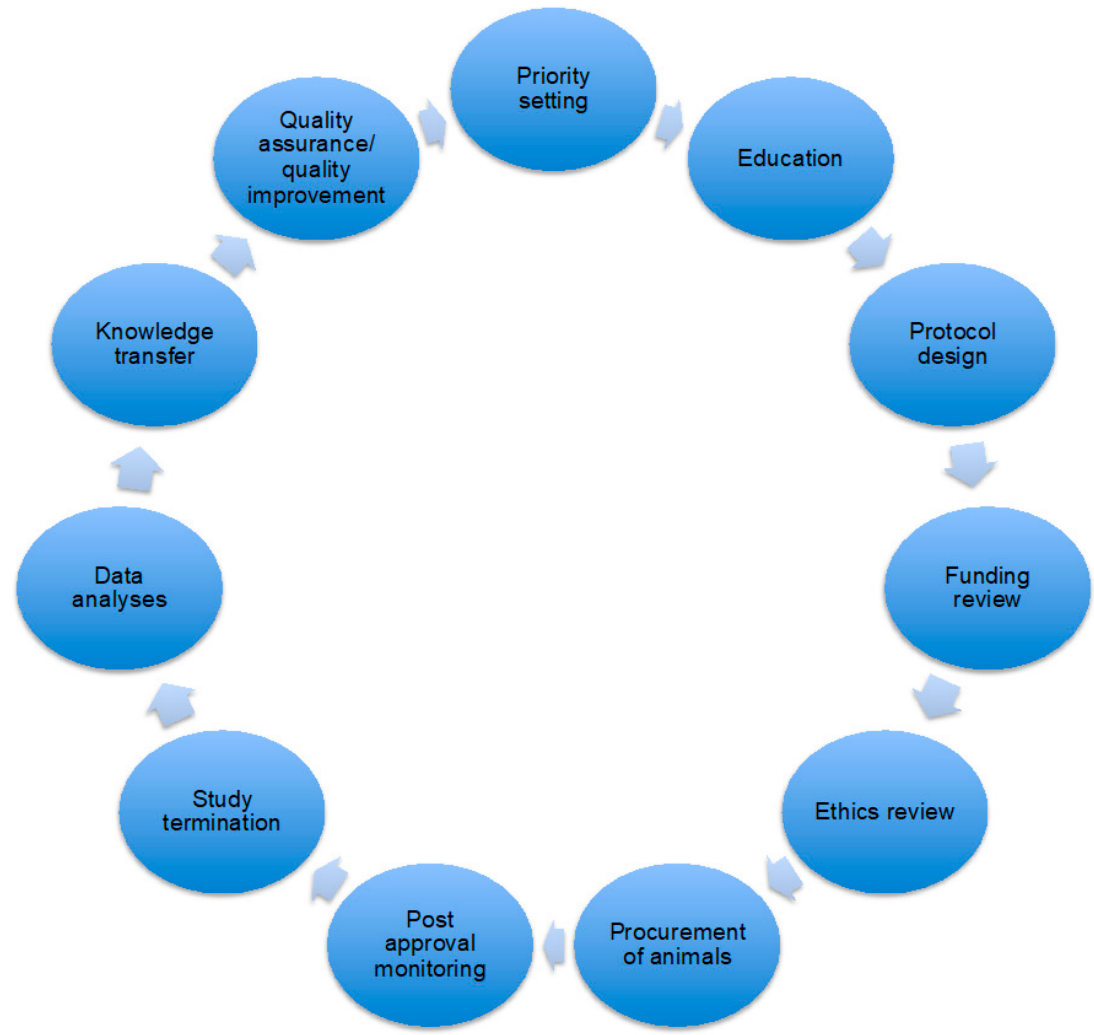
Figure 1. Proposed virtuous, self-reflexive learning loop for animal-based research that would focus on ethical reflection. Ethical reflection would no longer be limited to the ethics review component (adapted from [38]). Animal manipulation occurs from the procurement of animals to the study termination, so it represents a relatively small part of the process of animal-based